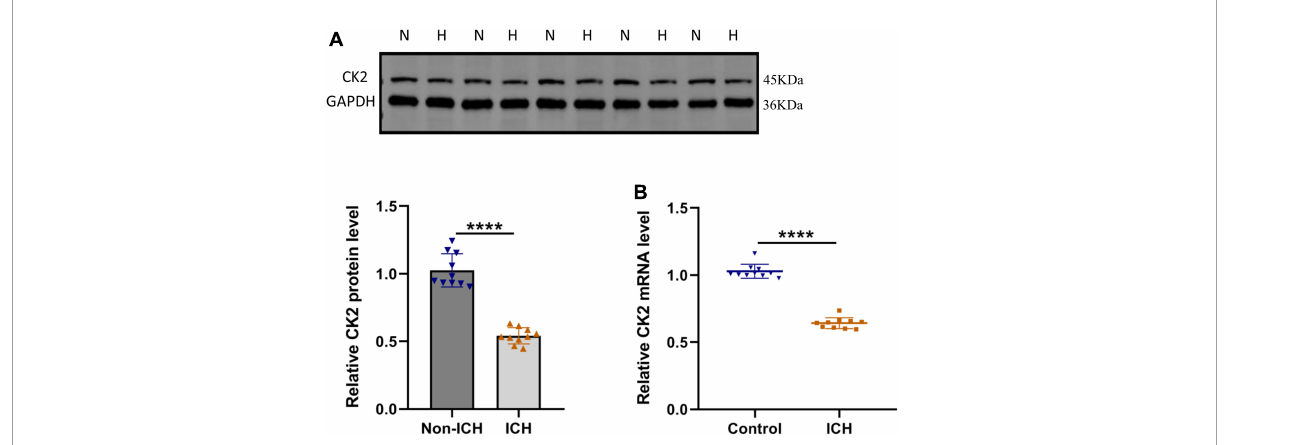
FIGURE1 CK2 was downregulated in patients with intracerebral hemorrhage. (A) Representative blots and summary data show CK2 protein level in the brain tissues from ICH patients or non-hemorrhagic controls ( n = 10). (B) Relative mRNA levels of CK2 were analyzed ( n = 10). The experiment was repeated three times independently. Data were shown as mean ± SD and he values between groups were compared by Student’s t -test. **** P <